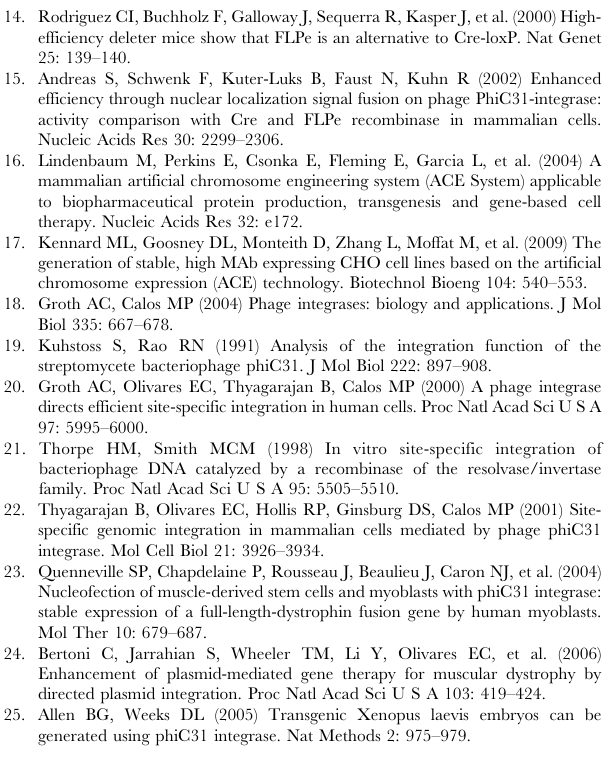
Figure S1 Nucleotide sequence of mammalian codon- optimized W C31 integrase. The nucleotide sequence of W C31 integrase used in this study. A mammalian codon-optimized W C31 integrase gene was synthesized de novo according to the native W C31 integrase amino acid sequence. Figure S2 Nucleotide sequence of the mammalian codon-optimized R4 integrase. The nucleotide sequence of the R4 integrase used in this study. A mammalian codon- optimized R4 integrase gene was synthesized de novo according to the native R4 integrase amino acid sequence.